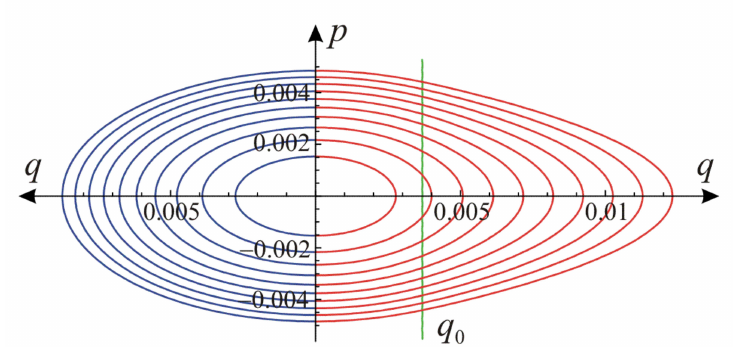
Figure 1. Contours of elastic strain energy for a linear material with K 0 = 56,700 MPa, G 0 = 26,200 MPa (left part, blue contours), and for the nonlinear material with: K 0 = K = 56,700 MPa, G 0 = 26,200 MPa, G = 100 MPa, q 0 = 0.003688, n = 3 (right part, red contours).